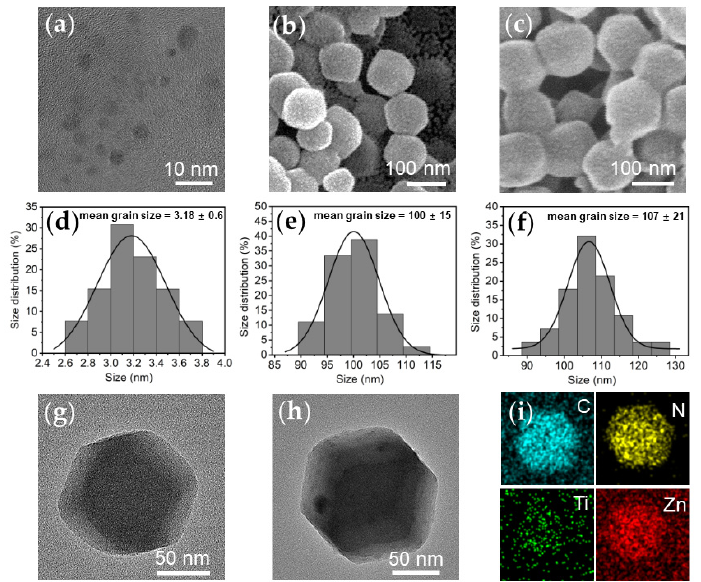
Figure 1. ( a ) TEM image of MQD; ( b , c ) SEM images of ZIF-8 and MQD@ZIF-8 samples; ( d – f ) size distributions of MQD, ZIF-8, and MQD@ZIF-8 samples. ( g , h ) TEM images of ZIF-8 and MQD@ZIF-8 samples. ( i ) Element mapping of MQD@ZIF-8 sample.